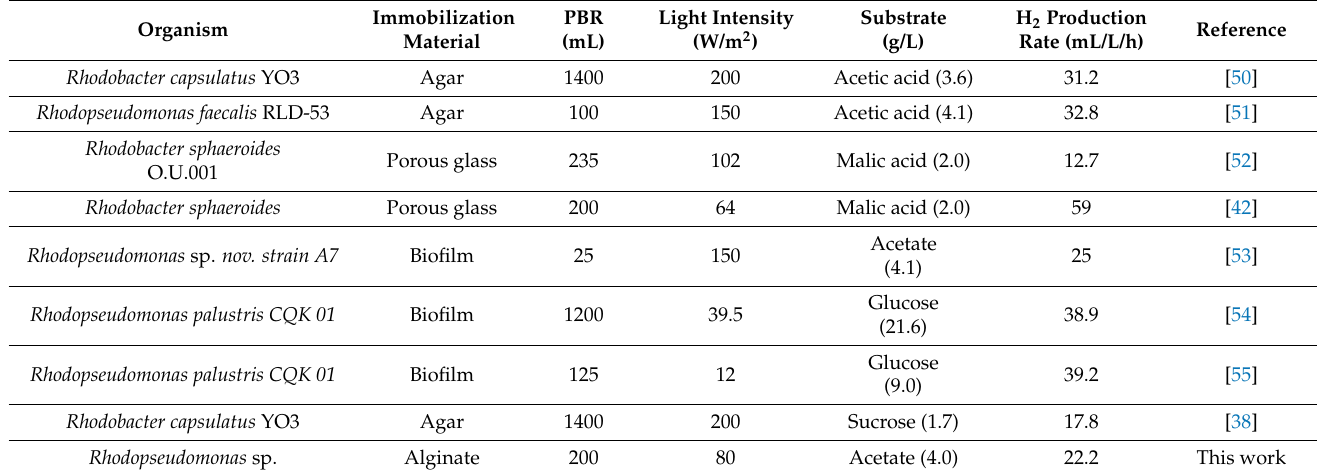
Table 1. Comparison of H 2 production studies of immobilized photosynthetic bacteria